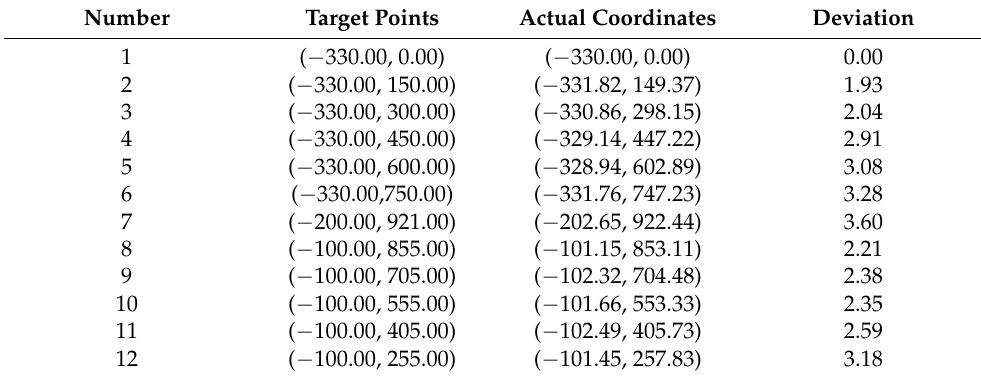
Table 5. “Improved U”path cruise test data Unit: